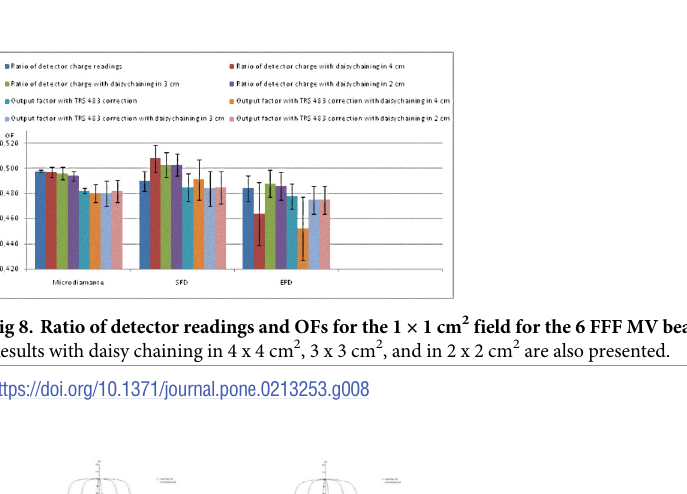
Fig 7. Ratio of detector readings and OFs for the 0.6 × 0.6 cm 2 field for the 6 FFF MV beams with different detectors. Results with daisy chaining in 4 x 4 cm 2 , 3 x 3 cm 2 , and in 2 x 2 cm 2 are also presented.